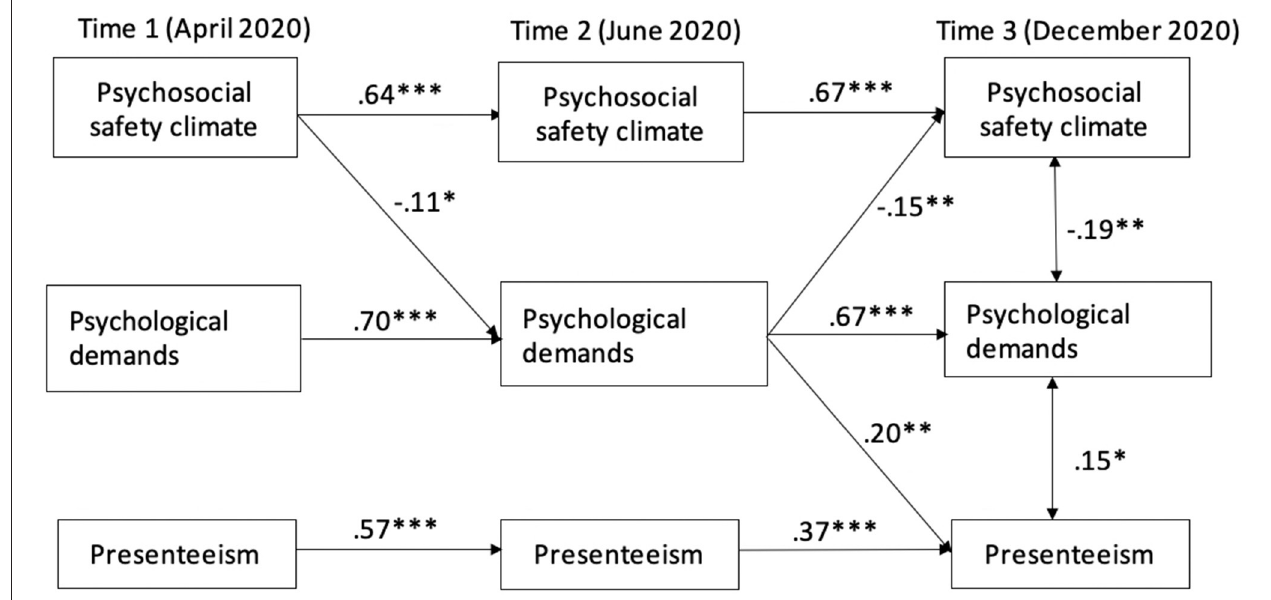
FIGURE 1 | Three-wave mediation model of psychosocial safety climate and presenteeism for teleworkers ( n = 275). * p < 0.05, ** p < 0.01, *** p < 0.001.